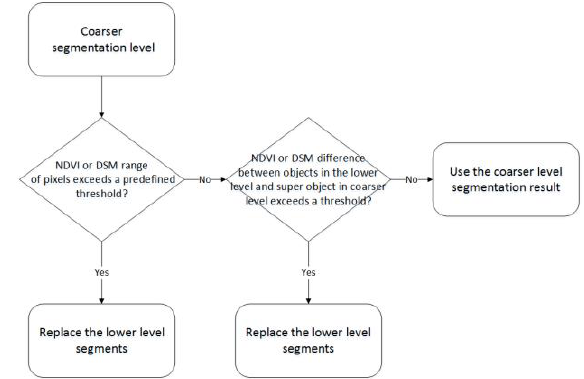
Figure 3. Process of segmentation scale space optimization